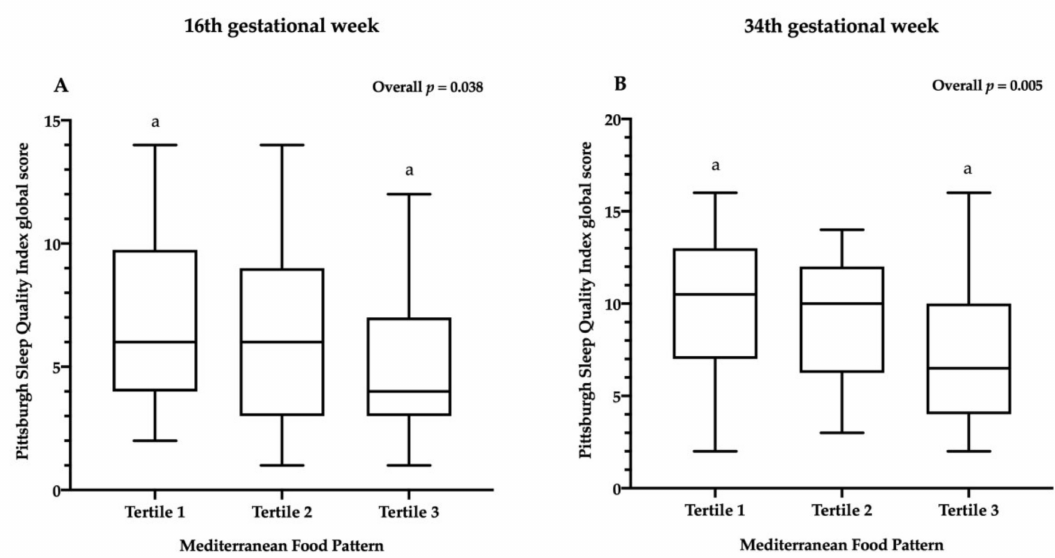
Figure 2. Pittsburgh Sleep Quality Index global score by tertiles of Mediterranean Food Pattern adherence. Box plots demonstrating median, upper and lower quartiles and the minimum and maximum Pittsburgh Sleep Quality Index global scores at the 16th ( n = 150) and 34th ( n = 118) gestational weeks. a—indicates a significant di ff erence ( p < 0.05) between groups. Pairwise comparisons were performed with Bonferroni‘s adjustment. ( A ) Pittsburgh Sleep Quality Index global score by the Mediterranean Food Pattern tertiles at the 16th gestational week. ( B ) Pittsburgh Sleep Quality Index global score by the Mediterranean Food Pattern tertiles at the 34th gestational